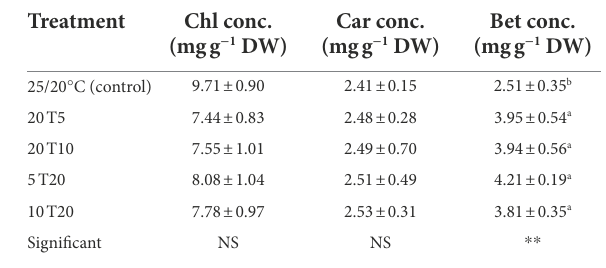
Data are mean ± standard error of four biological replicates. Means within columns were compared using Tukey’s HSD. Different letters indicate significant differences within column. The asterisks indicate the significance level ( ** p < 0.01). NS indicates no statistical significance. DW, dry